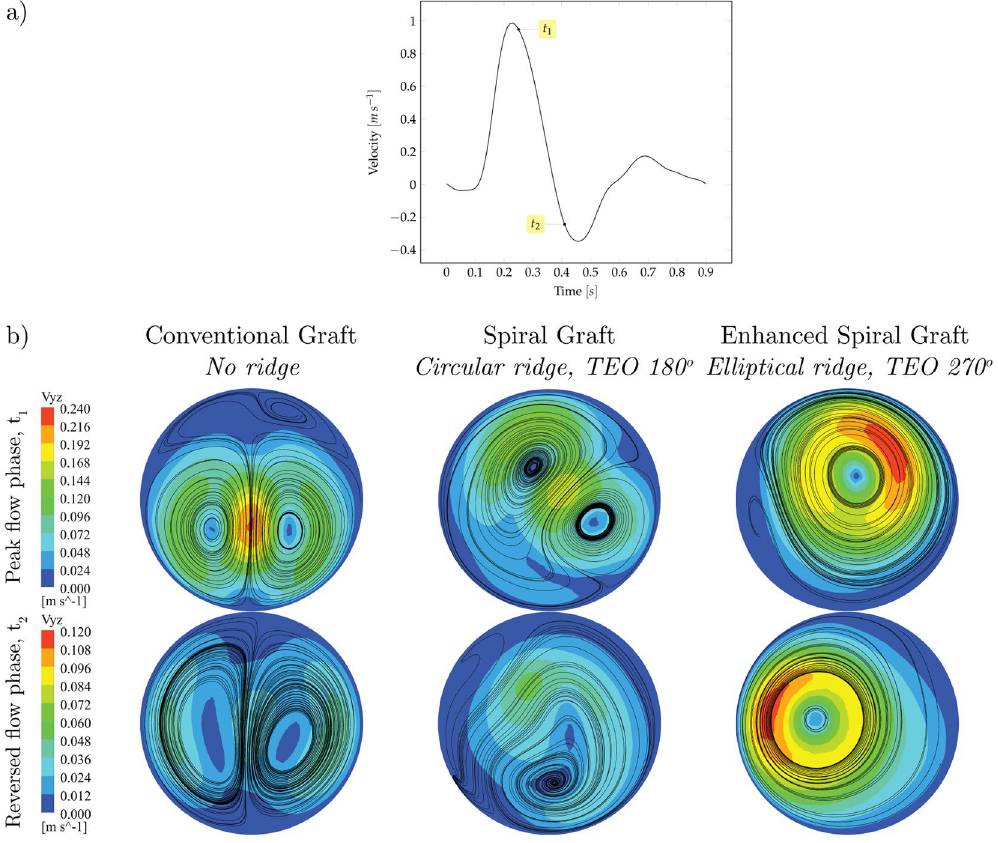
Figure 6. ( a ) Velocity waveform at the inlet and ( b ) contours of secondary velocity and crossflow streamlines at monitoring plane 3 and at peak (t 1 ) and reversed (t 2 ) flow